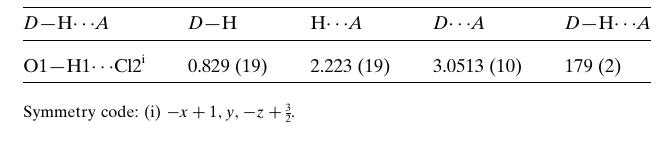
Table 2 Experimental details.